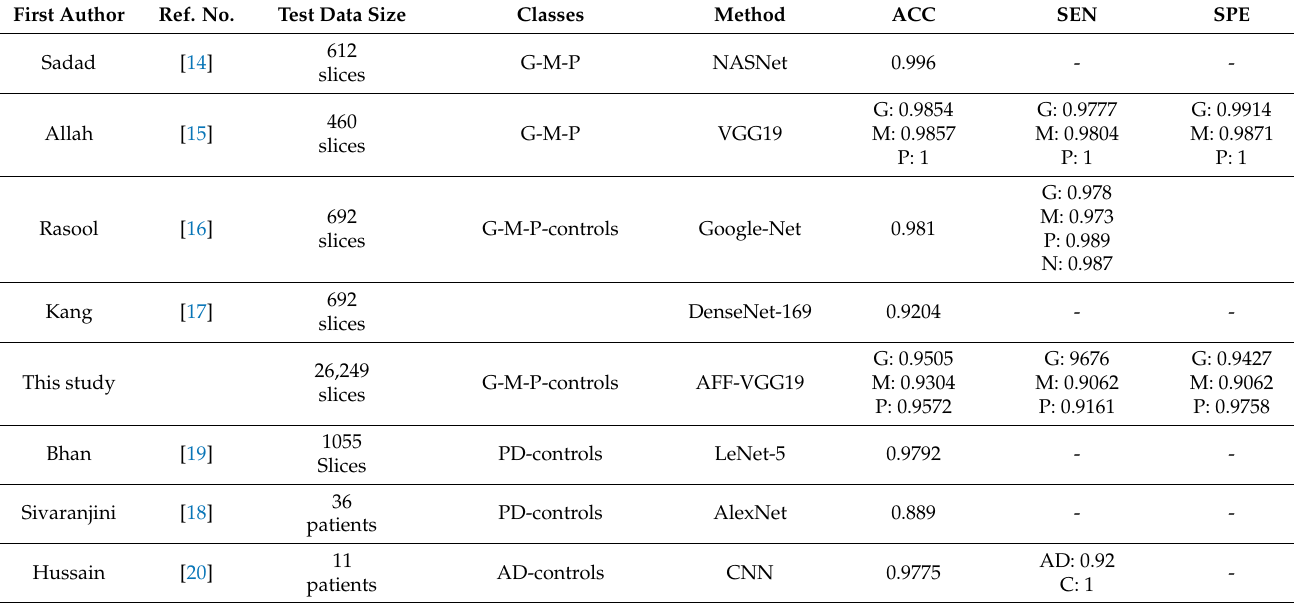
Table 6. Comparisons with related